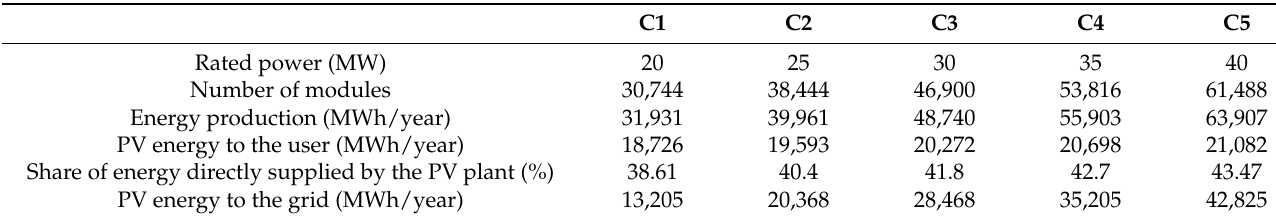
Table 3. PV plant characteristics and energy production in the five cases considered.